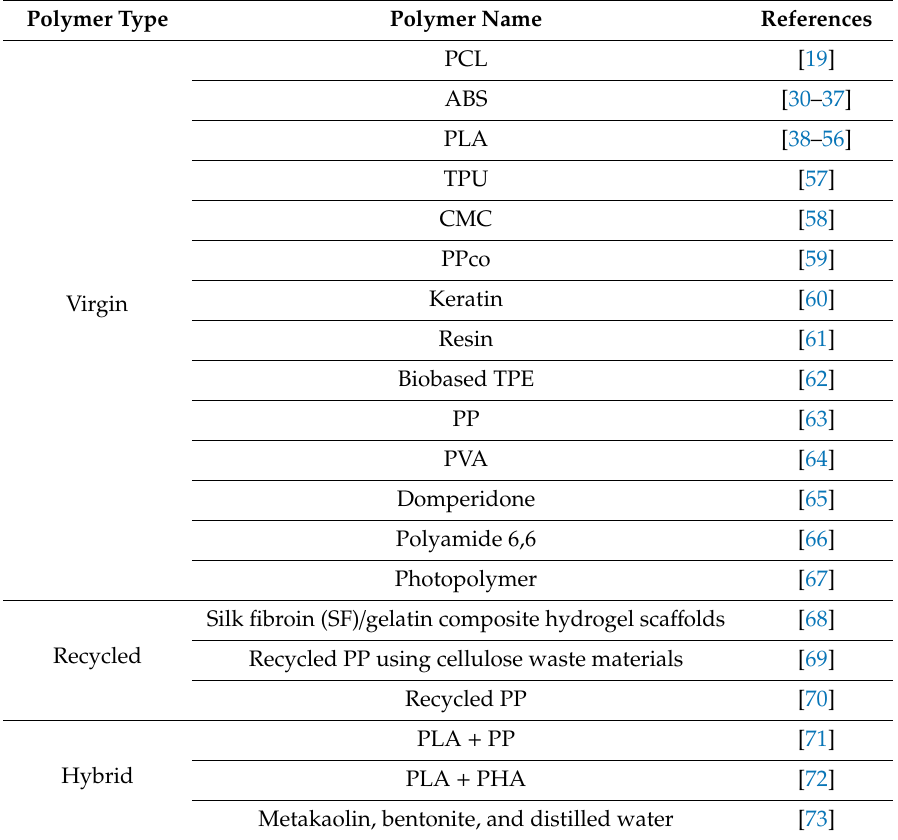
Table 1. Types of